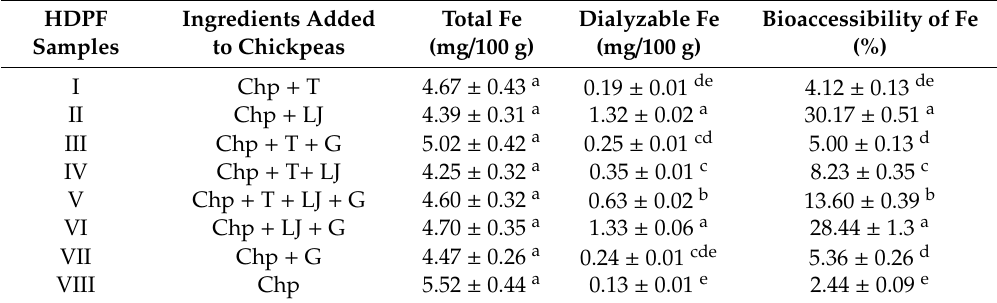
Table 3. Total iron (mg / 100 g), dialyzable iron (mg / 100 g), and accessible iron (%) in the eight samples of hummus with di ff erent processing and formulations (HDPF I → VIII ).